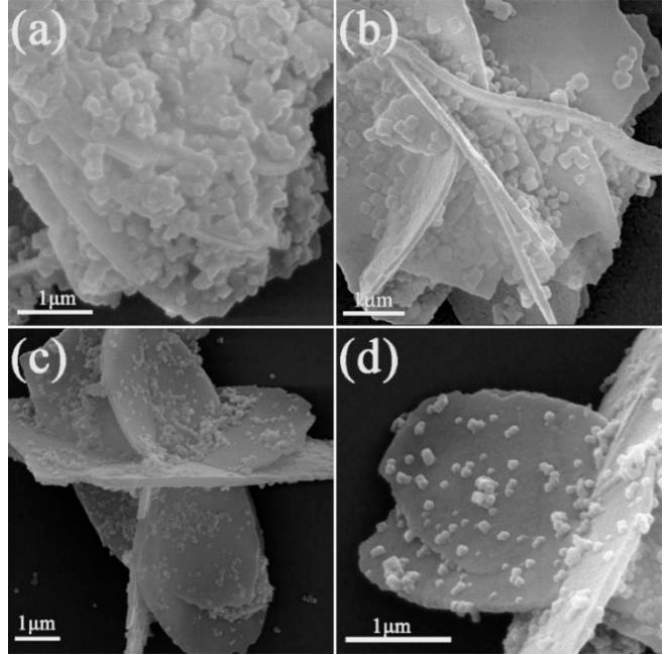
Figure 8. SEM morphologies of Ce/UN composites with different proportions: ( a ) 0.5:1; ( b ) 1:1; ( c ) 1.5:1; ( d ) 2:1.